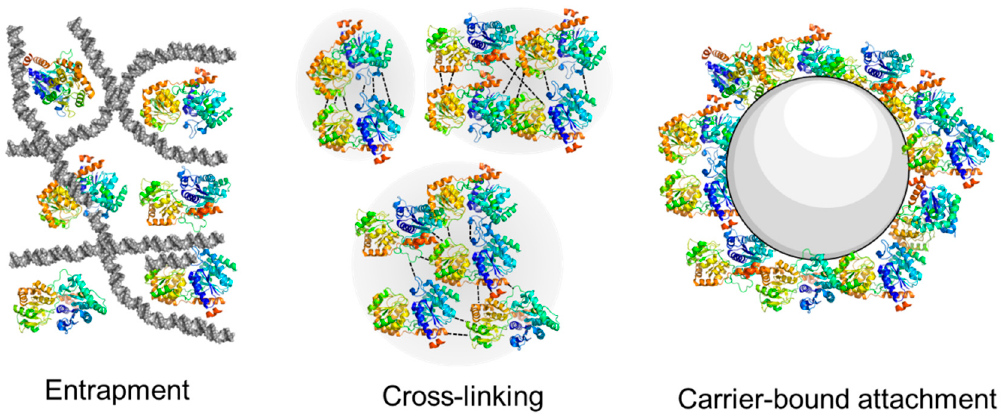
Figure 14. Di ff erent modes of immobilization of Leloir glycosyltransferases with entrapment, Figure 14. Different modes of immobilization of Leloir glycosyltransferases with entrapment, cross-linking, or carrier-bound cross-linking, or carrier-bound attachment.